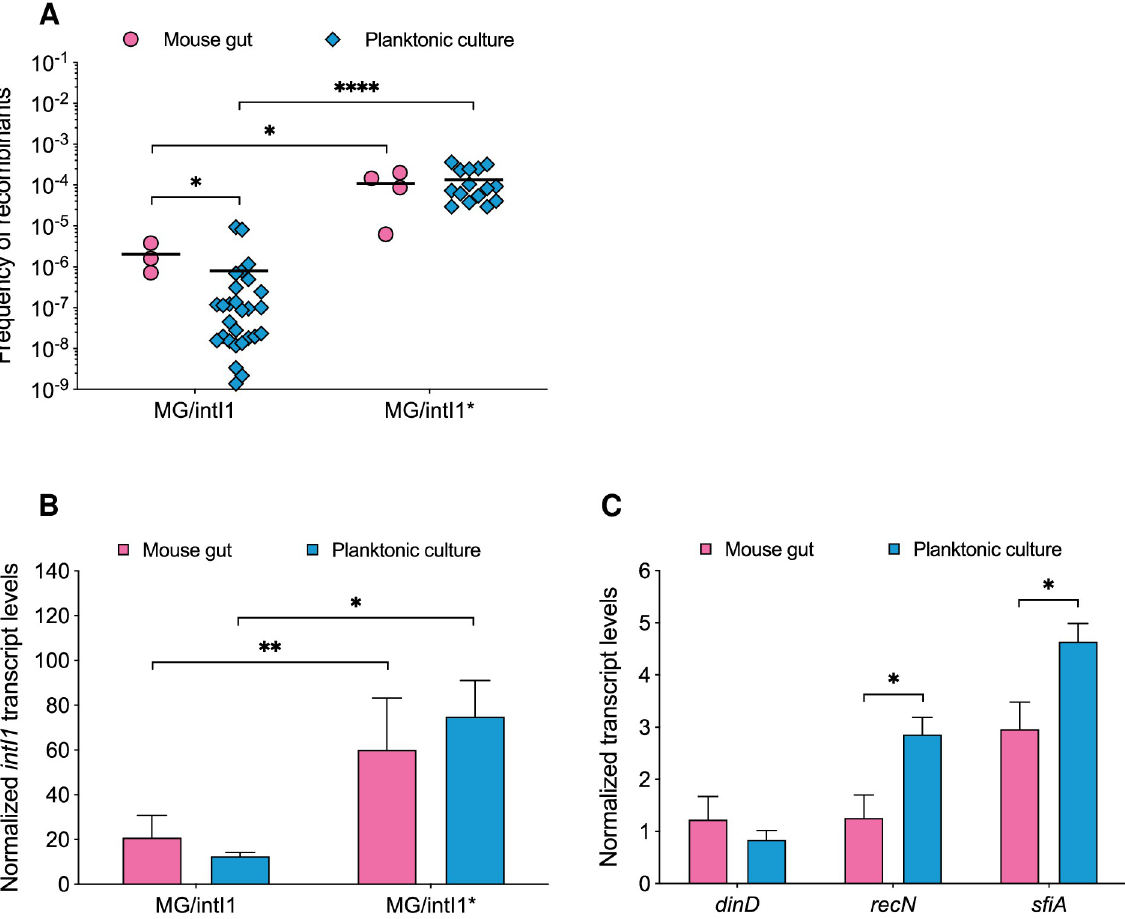
Fig 3. Comparisons of recombination activity of IntI1 and expression of intI1 and SOS regulon genes, in vivo versus in vitro . (A) Recombination activity of IntI1, reflected by the frequency of recombinants (FR), was estimated by determining the frequency of emergence of tobramycin-resistant recombinants, as a result of specific recombination between attC sites located on a synthetic array of two cassettes ( attC aadA7 - cat(T4) - attC VCR2 -aac(6’)-Ib � ) carried on plasmid p6851. The FR was calculated in MG/intI1 (carrying p6851 and pZE1intI1 allowing the expression of intI1 SOS-regulated) and MG/intI1 � (carrying p6851 and pZE1intI1 � allowing the constitutive expression of intI1 ), in the mouse gut and in 24-h-old-planktonic cultures. Each symbol represents the FR calculated from a single mouse exhibiting recombinants on days 2 and 3 post inoculation (n = 3 for MG/intI1 and n = 4 for MG/intI1 � ) and from planktonic cultures (n = 28 for MG/intI1 and n = 15 for MG/ intI1 � ). For each condition, the average FR is shown as a black horizontal line. Transcript levels of (B) the intI1 gene in MG/intI1 and MG/ intI1 � and (C) the SOS regulon genes dinD , recN and sfiA , in MG/intI1 in the mouse gut and in 24-h-old-planktonic cultures are represented. Transcript levels were normalized to the housekeeping gene dxs . Error bars indicate the SD. Differences were determined using the Mann- Whitney U test. � p < 0.05, �� p < 0.01 and ���� p < 0.0001.